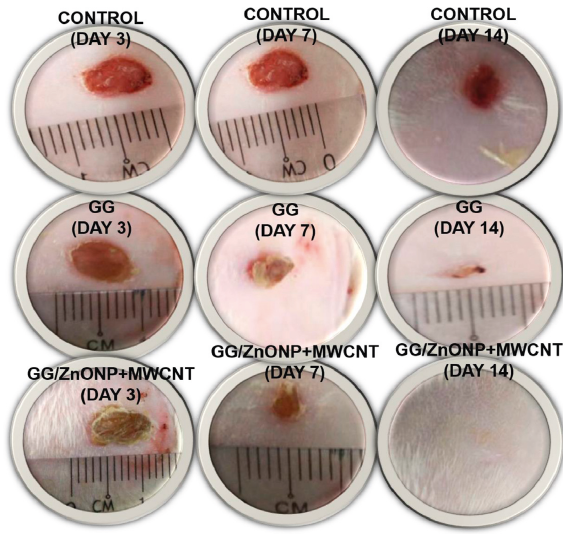
Figure 8: Macroscopic examination of untreated wounds as control sample and treated with pure GG and GG/ ZnONP+MWCNT bionanocomposite films on 3 rd , 7 th , and 14 th